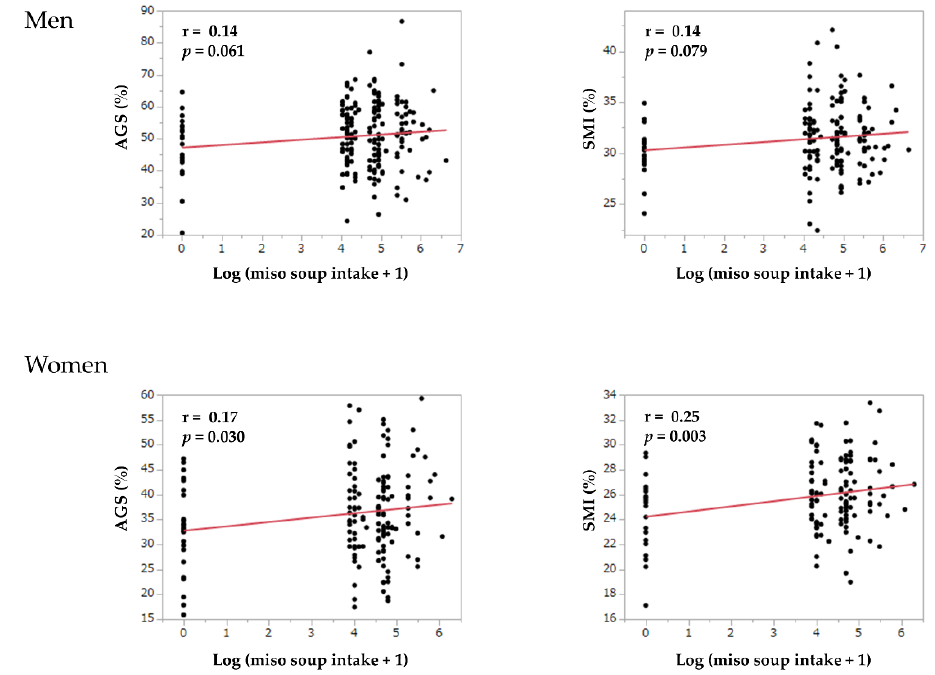
Figure 2. The correlation between miso soup intake and skeletal muscle mass or muscle strength. AGS, adjusted grip strength; log, logarithm; SMI, skeletal muscle mass index.